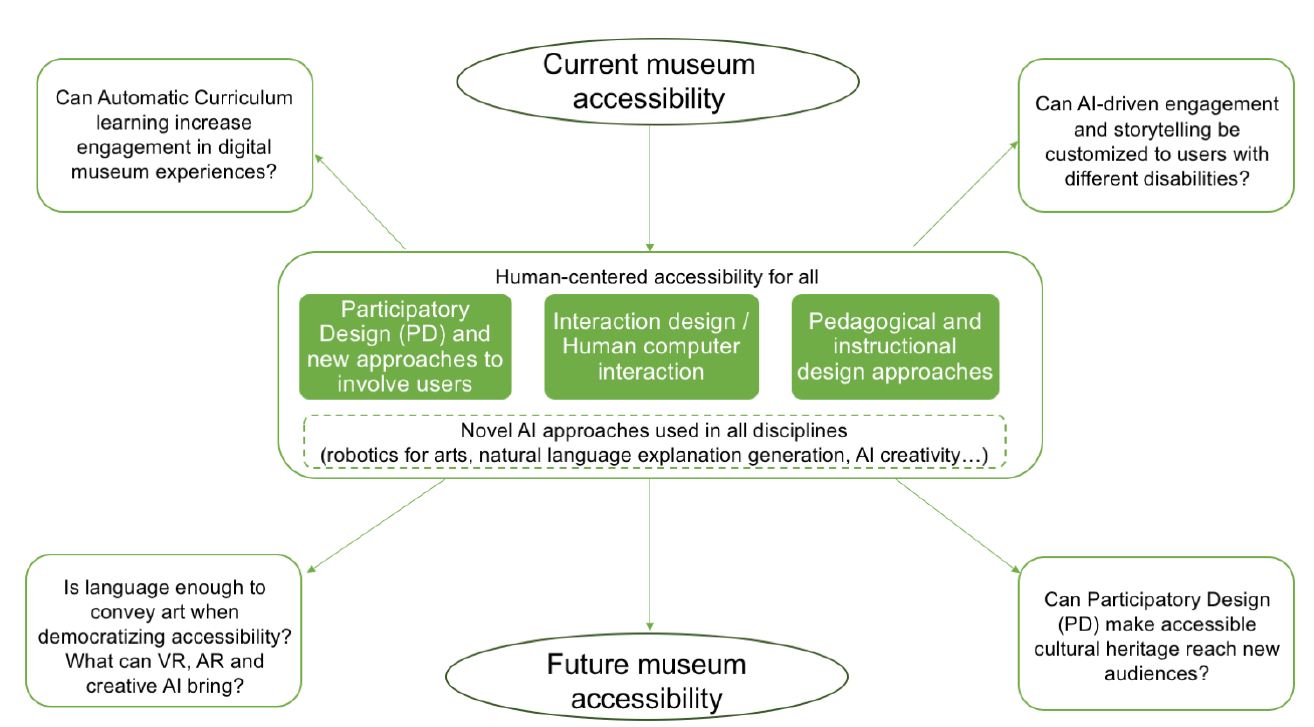
Figure 1. Conceptual framework for AI-enabled accessibility of museums and cultural heritage sites. Novel AI components include the concepts of learning progress in curiosity-driven exploration [11], pedagogical agents [14], creative AI, natural language explanation generation, accessible CH through explainable AI [93] and automatic curriculum learning